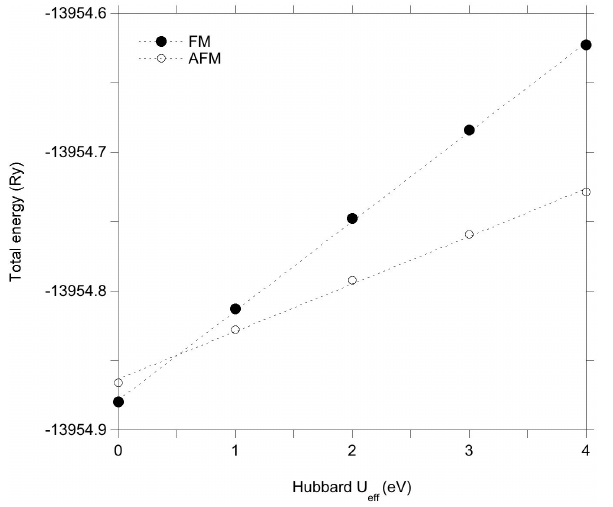
Figure 4. Relation between theoretical OH-stretching frequency ( ω OH ) and OH bond length ( d (OH)) (Table 2). The PBE and PBE + U values are reported. The dashed line corresponds to the correlation determined on the dravite and Mg-foitite models (Fuchs et al., 2022): ω OH = 18668 − 15477 d (OH). Filled circles: W OH in Y Fe Y Al environment with AFM configuration; filled squares: 2 W OH in Y Fe Y Al environment with FM configuration; triangle: 2 W OH in Y Fe Y Al V OH groups; open cir- 2 configuration; diamonds: cles: Mg-bearing clusters (Fuchs et al.,